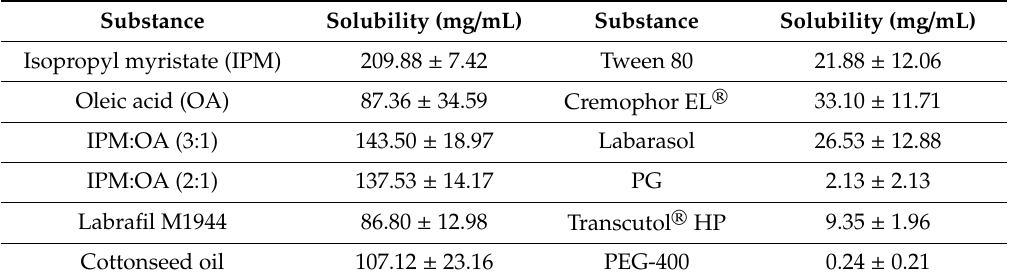
Table 1. Solubility of CoQ10 in various oils, surfactant, and co-surfactant at room temperature (mean ± SD, n =